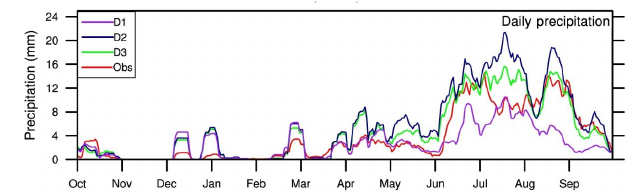
Figure 3. Daily station averaged precipitation (mmday − 1 ) from three WRF resolutions and observation (plotted as 10-day moving average). Observation abbreviated as “obs” hereinafter in all the fig-